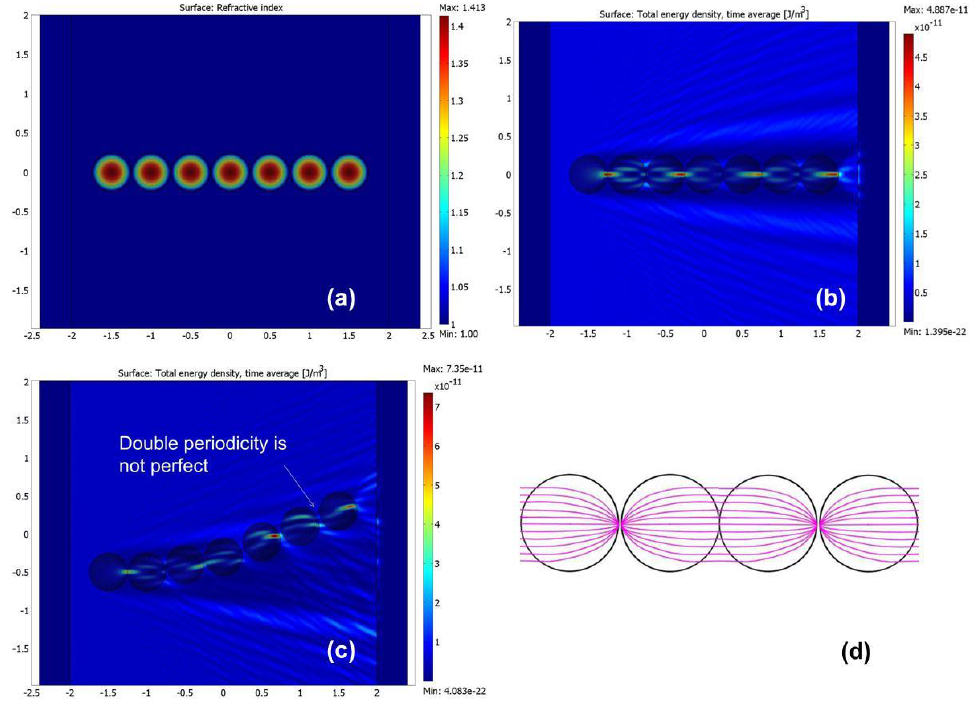
Figure 3. Theoretical simulations of a Luneburg waveguide using COMSOL Multiphysics ( a - c ) and ray optics ( d ). Panel (a) shows effective refractive index distribution for TM light in a straight Luneburg waveguide, while panel (b) shows calculated energy density within the waveguide. Numerically calculated TM light propagation through a curved Luneburg waveguide (c) illustrates that double periodicity is typically broken within such a